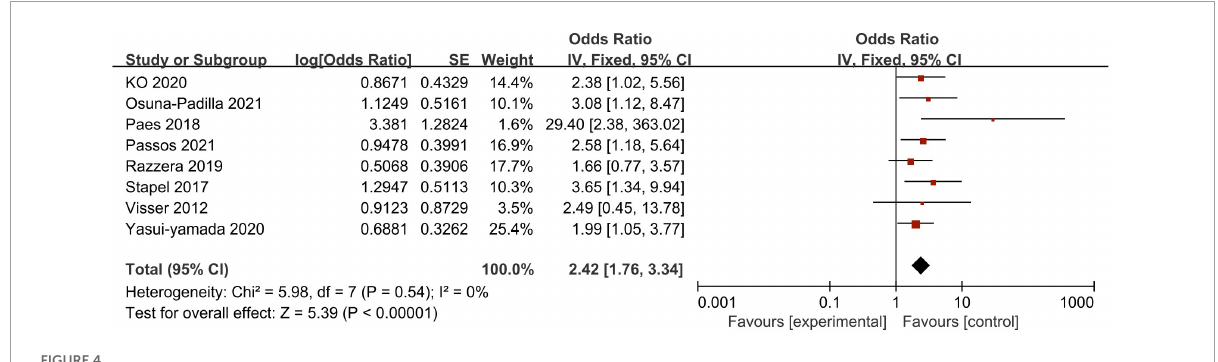
FIGURE4 Forest plot demonstrating the association between phase angle (as categorical variable) and mortality in critically ill patients and the pooled estimates.